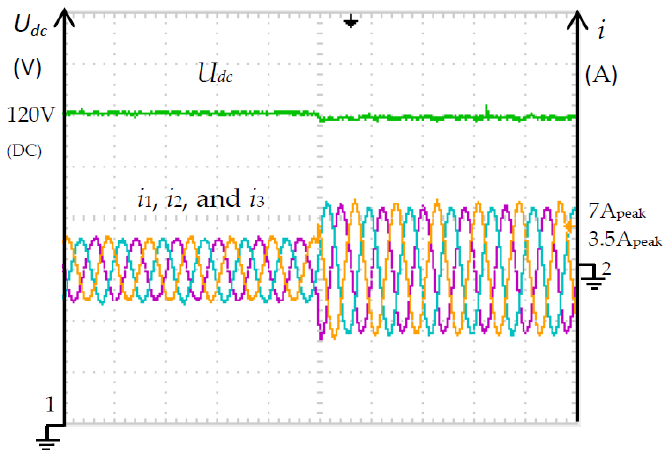
Figure 12. Experimental results of the DC voltage and AC currents, i 1 , i 2 , and i 3 , of the DC microgrid when there is a step change in load or generation. Increased load using a DC voltage PI controller. Vertical: 6 A/div and 20 V/div. Horizontal: 5 ms/div.